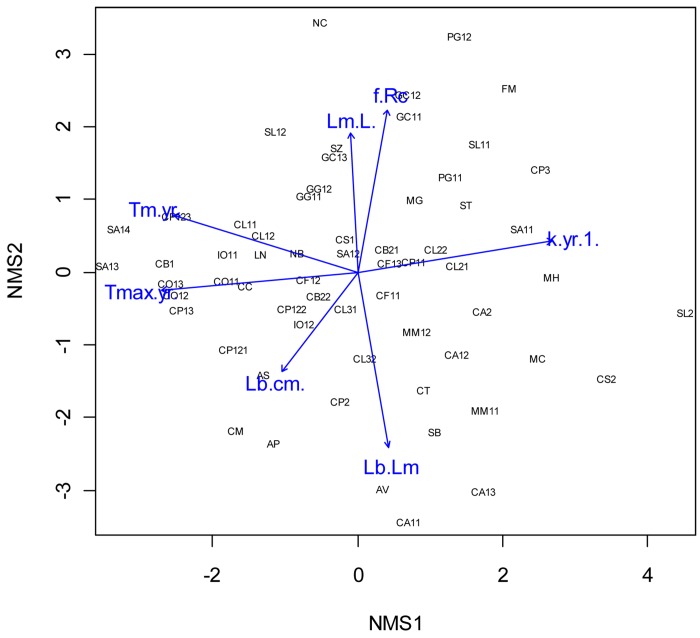
The biplot of two dimensional NMDS.Black labels are species, blue arrows are life history traits.